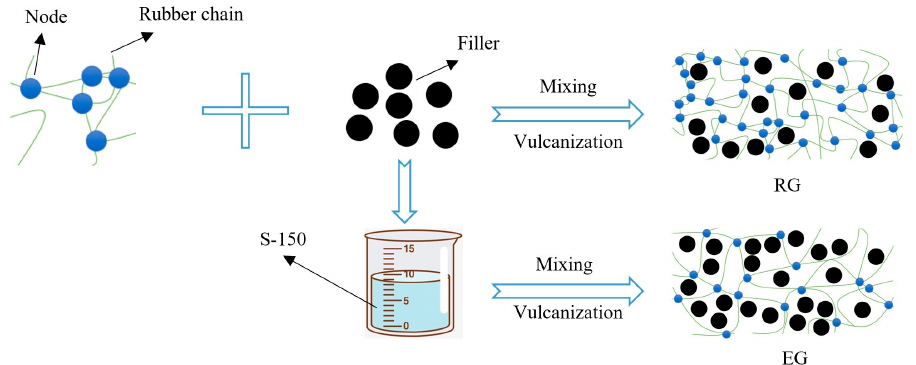
Figure 15. The schematic diagram of S-150 reinforcing rubber principle.